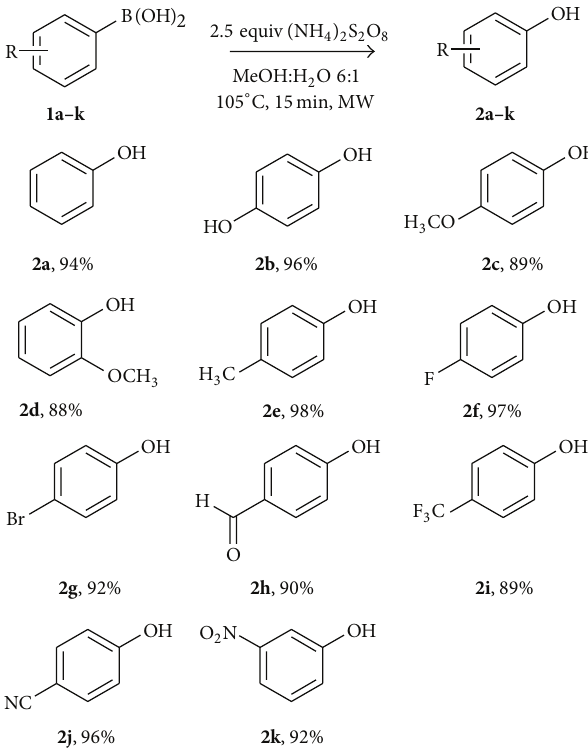
Scheme 2: Hydroxylation reaction of 1 a –1 k under microwave irra- diation. Reaction conditions: 1 a (0.41 mmol, 1equiv.), MeOH : H 2